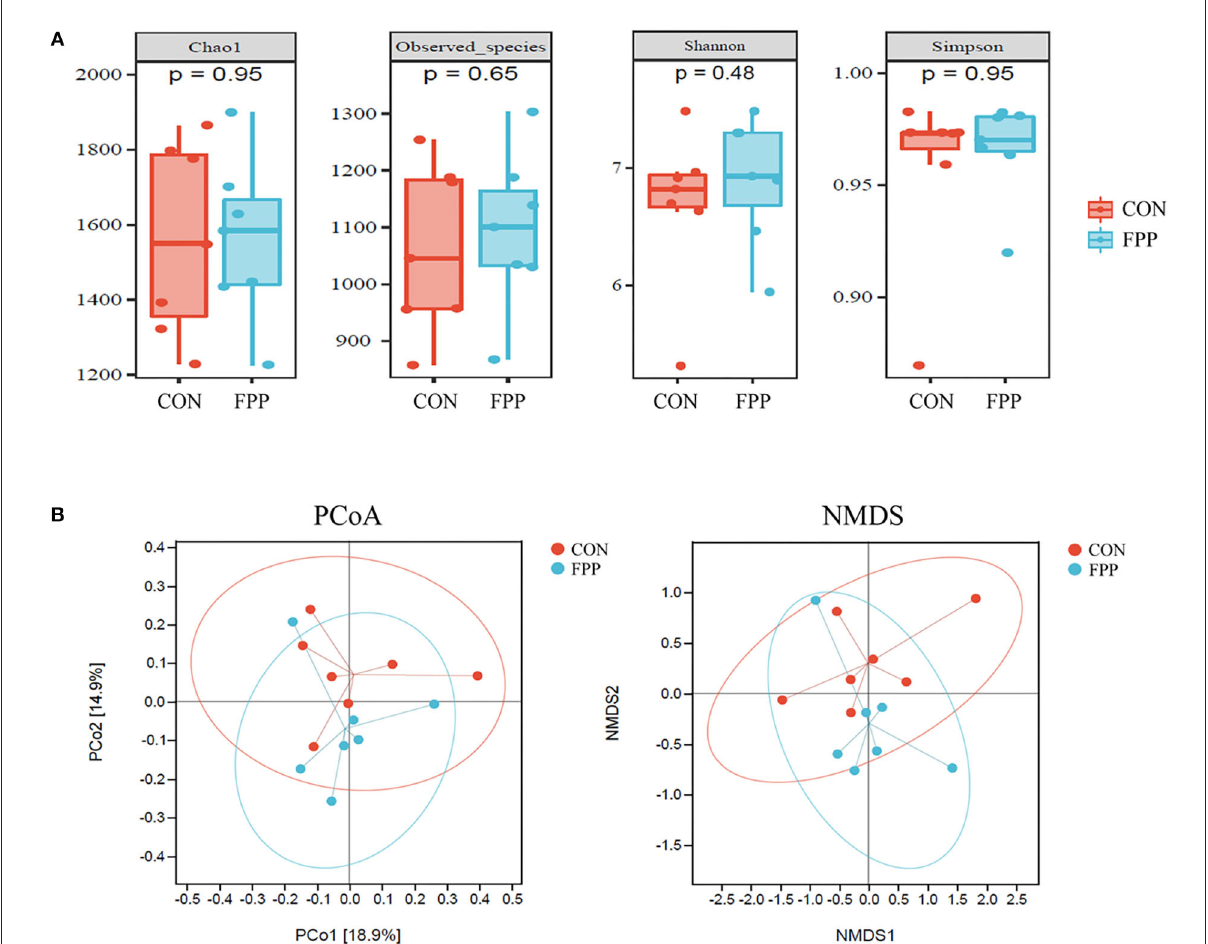
FIGURE3 Effect of fermented plant product on the bacterial community diversity of cecal microbiota in laying hens. (A) Alpha diversity of cecal bacteria in laying hens-fed basal diet supplemented with 0 (CON) and 500 mg/kg fermented plant product (FPP). Box plots indicate microbiome diversity differences of Chao1 diversity, observed species, Shannon diversity, and Simpson diversity in CON and FPP groups. (B) Beta diversity analysis of cecal microbiota in the CON and FPP groups. PCoA and NMDS based on Bray–Curtis distance were applied to identify the separation of the samples. Red and blue dots represent samples collected from laying hens in the CON group and the FPP group, respectively.